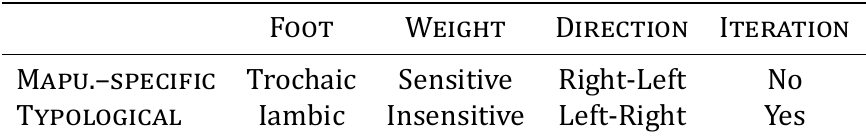
Table 1: Two competing accounts of stress placement in